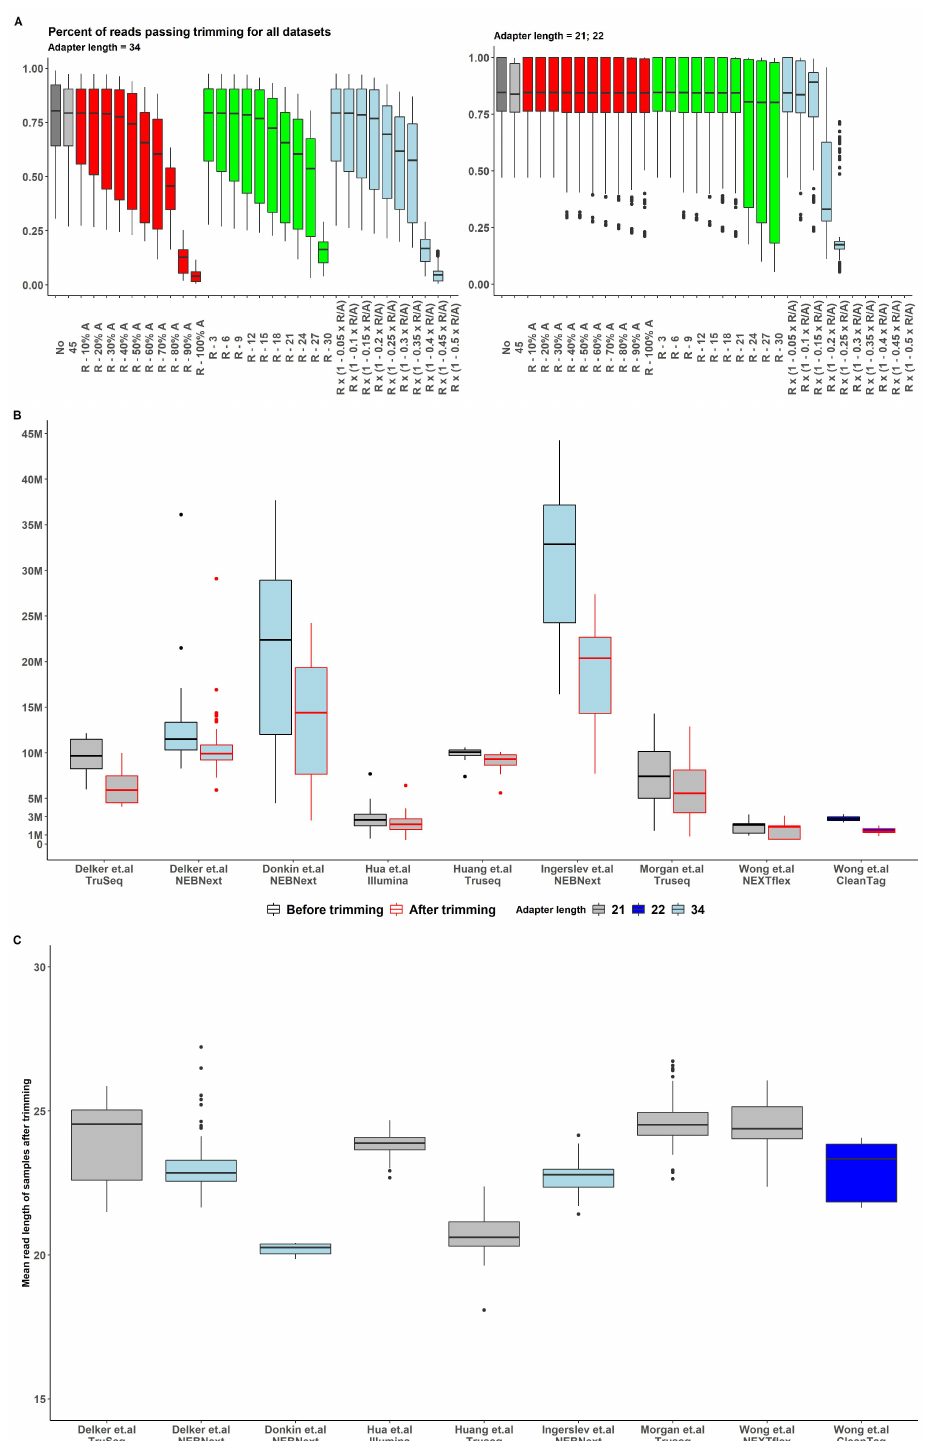
Figure 2. ( A ) Percent of reads passing trimming for all datasets with various upper-length bounds [58–64]. All reads were previously trimmed of adapters, and reads less than 15 nt were removed ( No boxplot). Upper-bound choosing strategy defined by color: 45 nt - grey, Read length − part of adapter length ( R − X % × Adapter length ) -red, Read length − fixed number ( R − X ) -green, Read length × ( 1 − X Read length - light blue. ( B ) Number of reads before (black border) and after (red border) trimming among datasets and adapter length (boxplot fill) for analyzed datasets [58–64]. ( C ) Mean read length after trimming for analyzed datasets